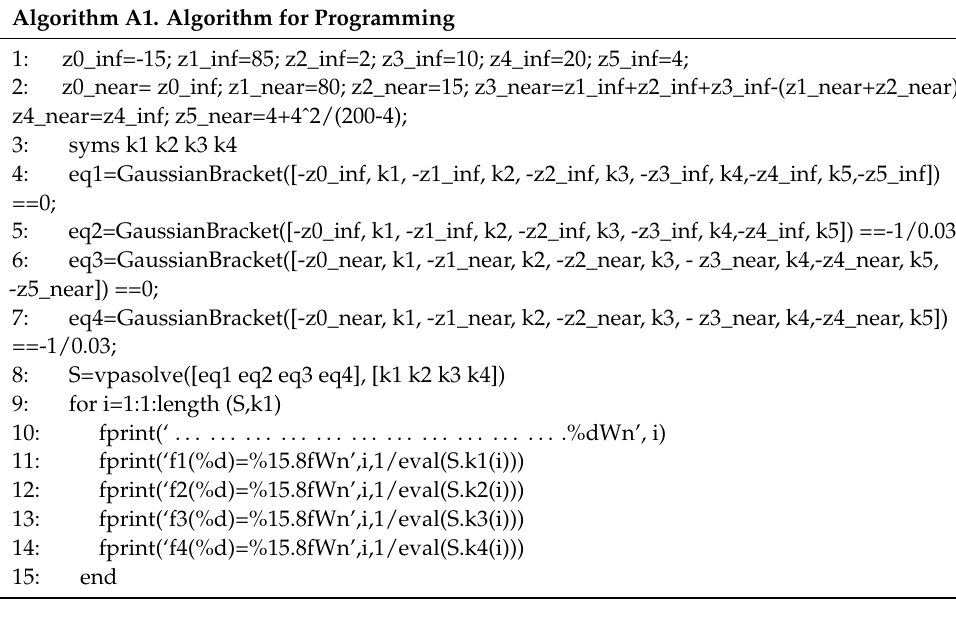
Algorithm A1. Algorithm for